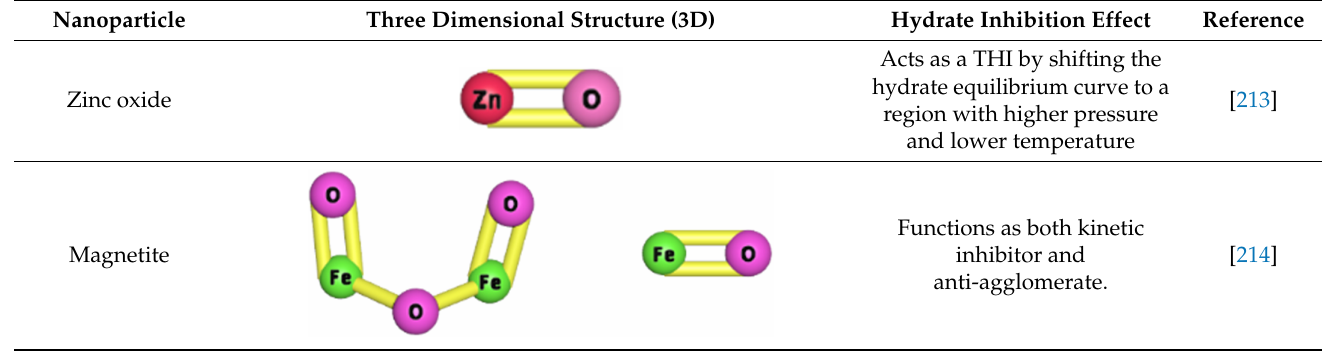
Table 13. Some of the widely used nanoparticles in hydrate inhibition